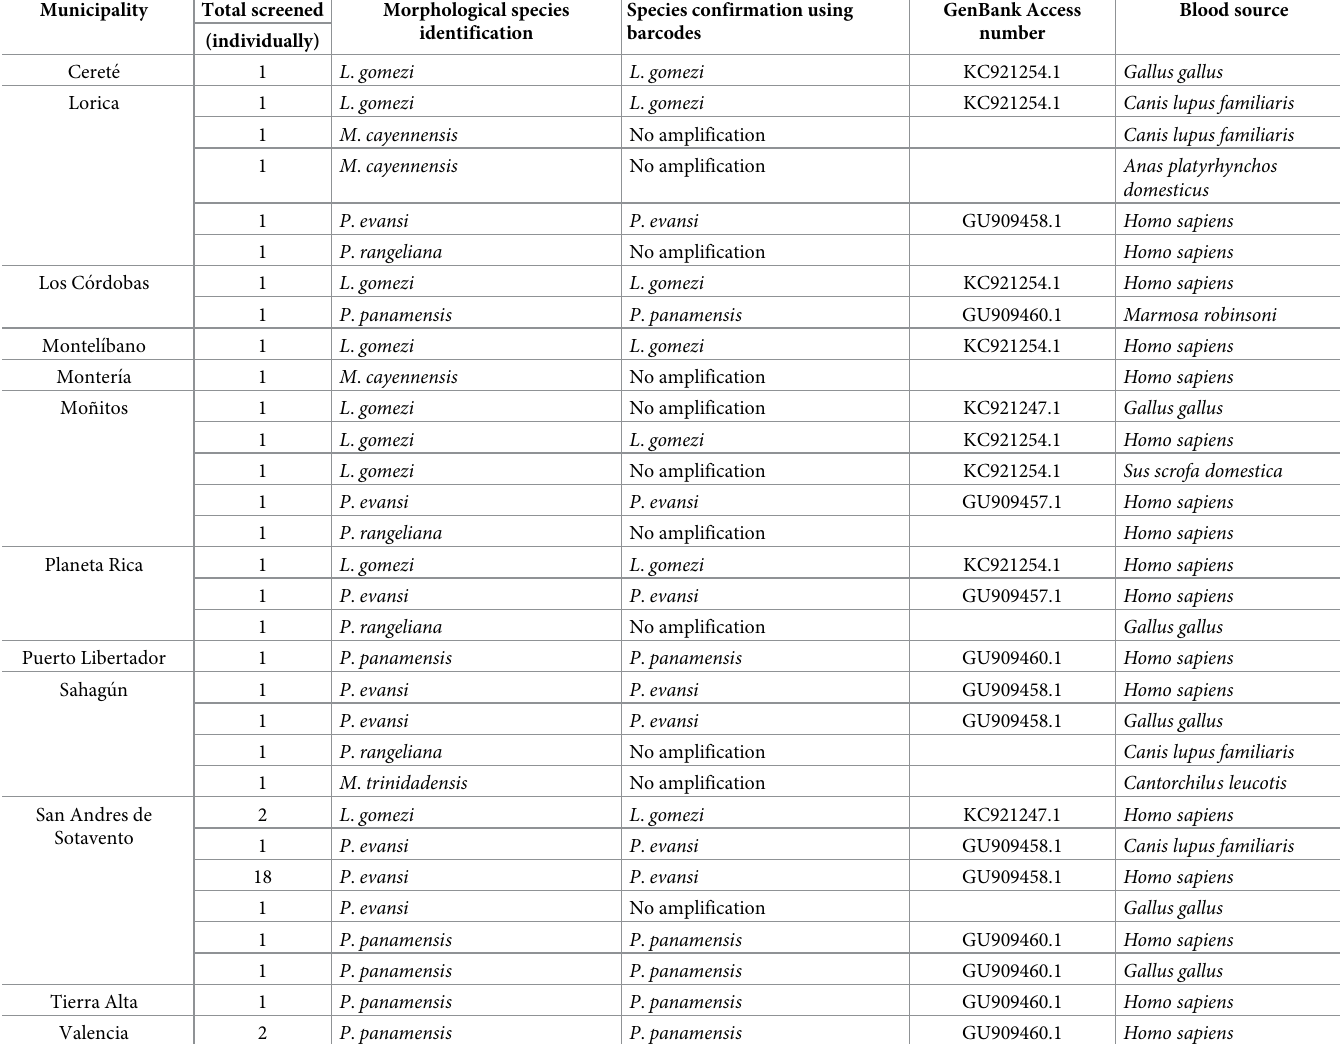
Table 4. Blood sources detected in sand fly specimens in each locality. Blood fed females were processed individually, identified based on external characters, and spe- cies confirmation was performed using DNA barcode procedures.